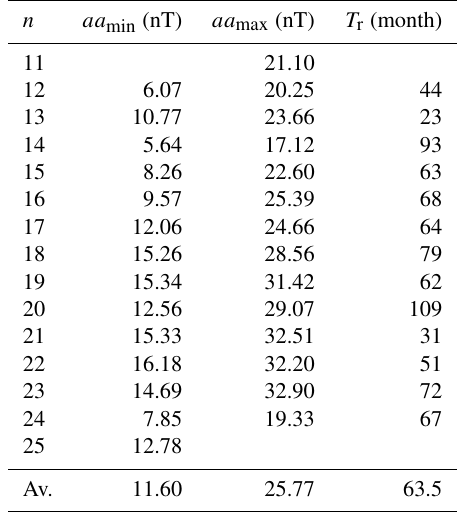
Table 3. Parameters of the 13-month smoothed monthly mean aa for the solar